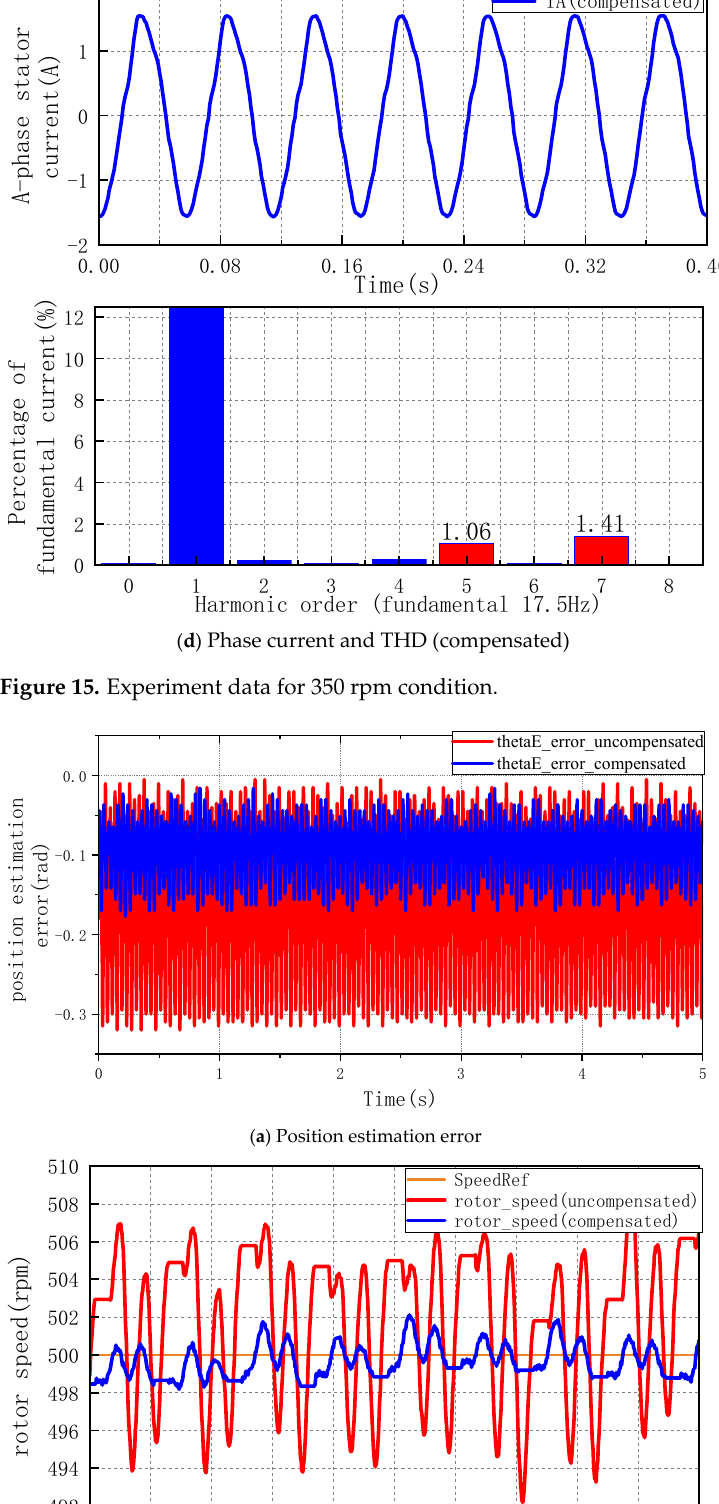
Figure 15. experiment data for 350 rpm condition.